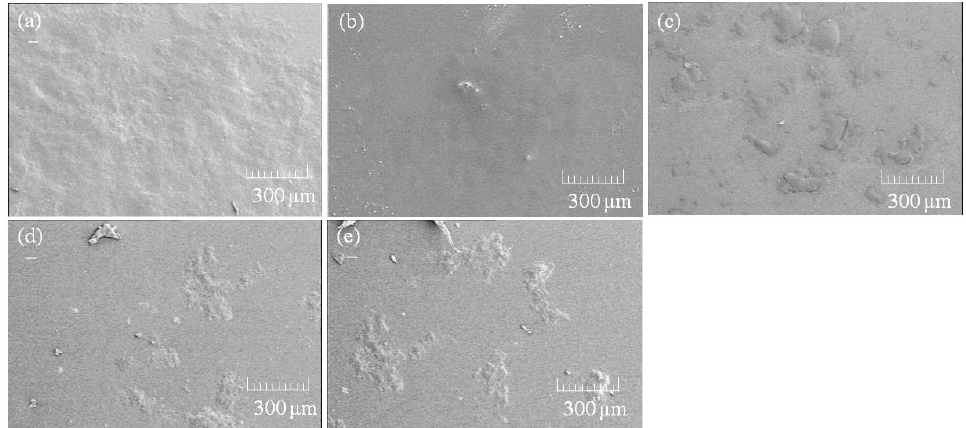
Figure 10. SEM images of ( a ) NR latex; and ( b – e ) self-assembled CNF-NR dispersions (CNF:NR (weight ratio) = 0.01, 0.02, 0.1, 0.2:1, respectively) after evaporation of ammonia.